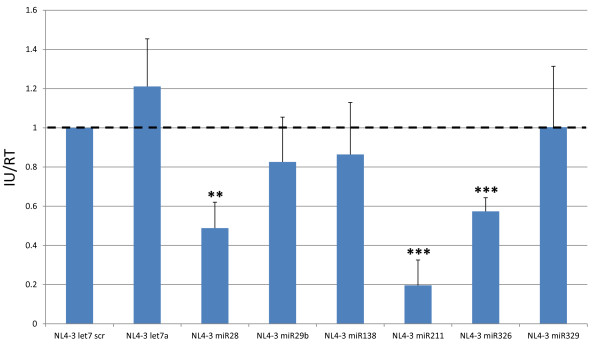
Analyses of viral stocks generated from transfection in 293T cells. 293T cells were seeded in a 6-well plate and transfected with 2 μg pNL4-3 let7 scr, pNL4-3 let7a, pNL4-3 miR28, pNL4-3 miR29b, pNL4-3 miR138, pNL4-3 miR211, pNL4-3 miR326 and pNL4-3 miR329. Supernatants were harvested at 48 hours post transfection and filtered to remove any contaminating cells. Supernatants were used to infect the HeLa derived TZMbl reporter cell line and to determine reverse transcriptase (RT) activity. Twenty-four hours after infection, the TZMBl cells were fixed and infected cells were visualized by β-galactosidase staining. Infectious units (IU)/RT were determined and graphed relative to NL4-3 let7 scr control. Data shown are the averages of three replicates. ** indicates a p-value < 0.01 and *** indicates a p-value < 0.001 compared to control.